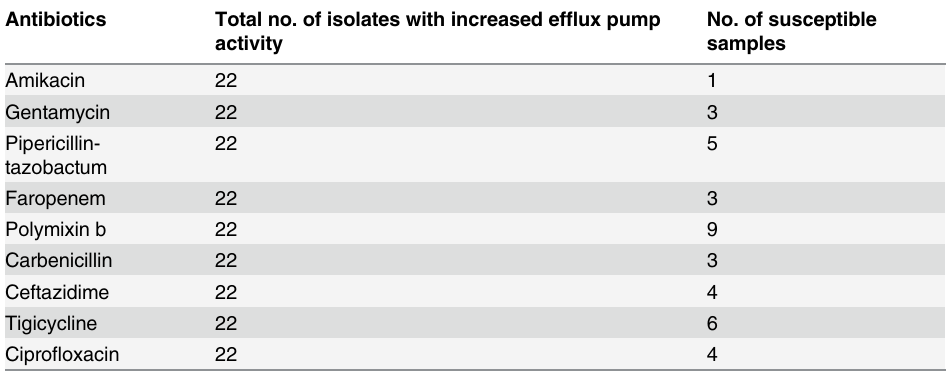
Table 3. Antibiogram of P . aeruginosa with increased efflux pump